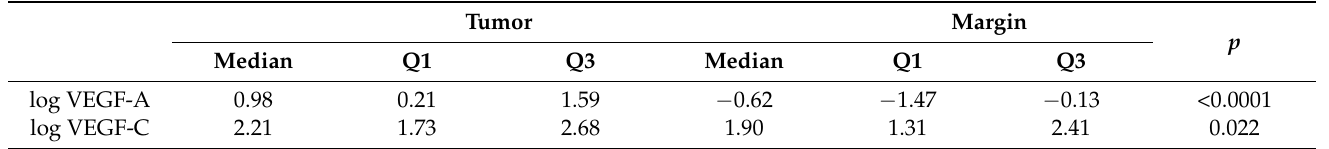
Table 3. Levels of VEGF-A and VEGF-C proteins in tumor and margin presented as log-transformed ng/mg of protein. Paired T-student’s